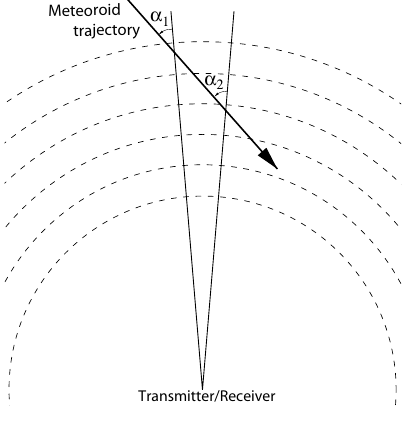
Fig. 11. Sketch of a meteoroid trajectory in the far-field of a radar beam (solid lines), where the phase fronts are spherical (dashed lines). The Doppler shift varies as cos α along the trajectory. For an approaching meteoroid: α 1 < α 2 .